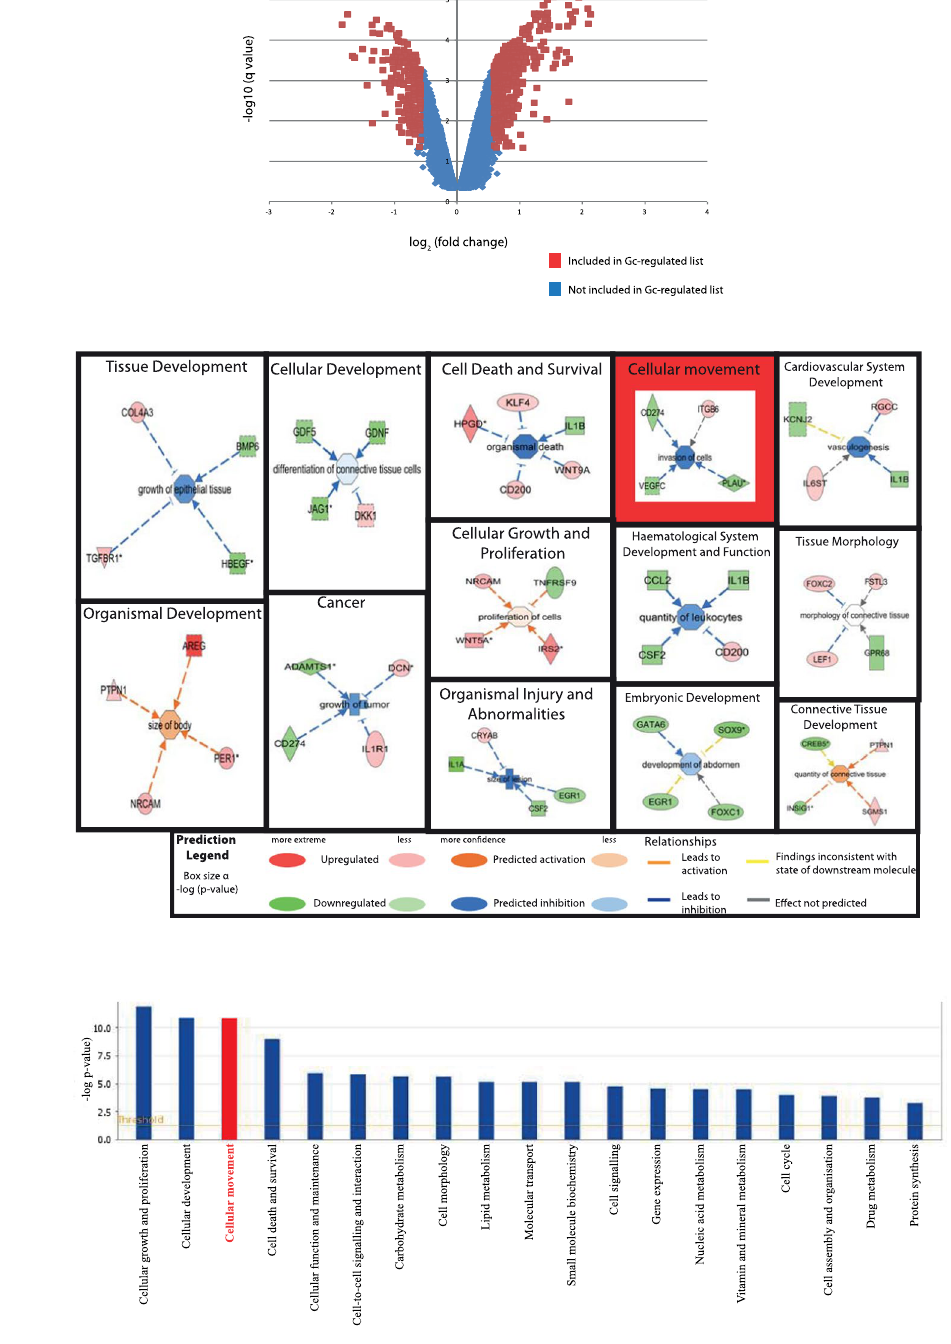
Figure 2. Microarray analysis of Gc-regulated genes. Microarray analysis was performed on transcripts from podocytes following 5 hour exposure to either prednisolone or vehicle. A fold-change in transcript expression of ± 1.5 and a q-value of < 0.05 between vehicle- and prednisolone-treated samples was considered significant, and this defined the list of Gc-regulated genes. ( a ) is a volcano plot showing the distribution of Gc-regulated transcripts. ( b ) This list of genes underwent pathway analysis using the following terms: ‘disease and disorders,’ ‘molecular and cellular functions’ and ‘physiological system development and function’ to understand the range of processes regulated by Gc. Significantly enriched terms are displayed, with the size of each box being inversely proportional to the p-value. Each displayed term has a pathway analysis example contained within the box, illustrating the relationship between transcriptional changes and effects on lower-order IPA pathway terms. ( c ) Podocyte Gc- regulated genes underwent pathway analysis using the term ‘molecular and cellular functions.’ Enriched terms are listed in order of significance. The orange line denotes a threshold level of significance corresponding to a p-value of 0.05. ‘Cellular movement’ was a term selected for further analysis and is highlighted in